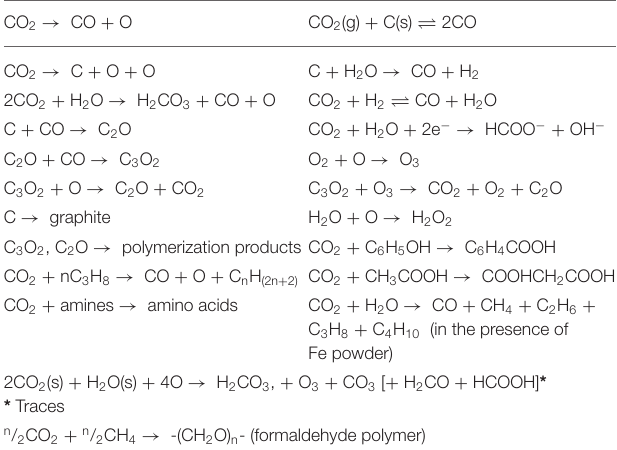
TABLE 1 | Summary of considered reactions induced by